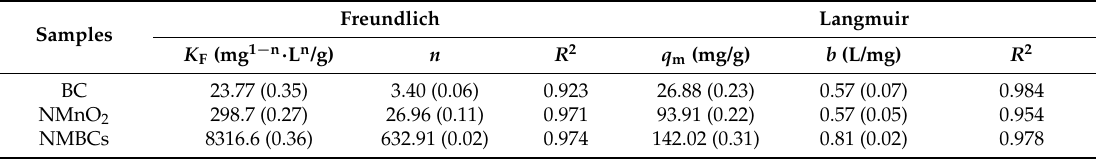
Table 3. Cu(II) adsorption isotherm parameters based on the Freundlich and Langmuir models.